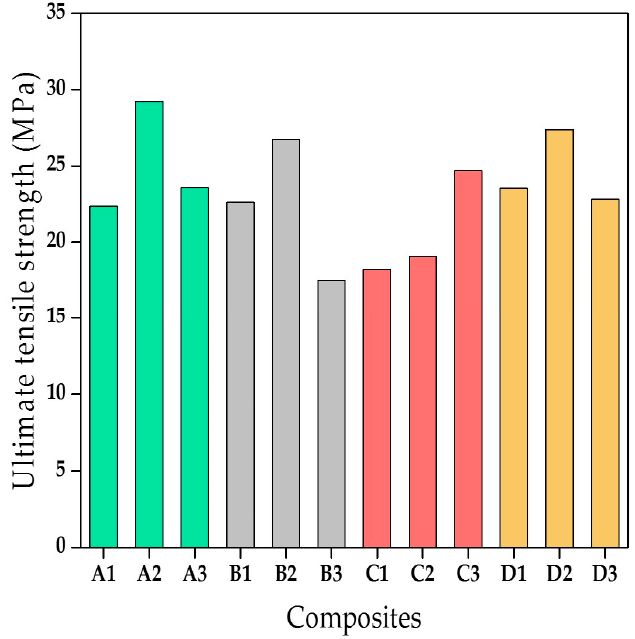
Figure 3. Tensile behaviour of composites.